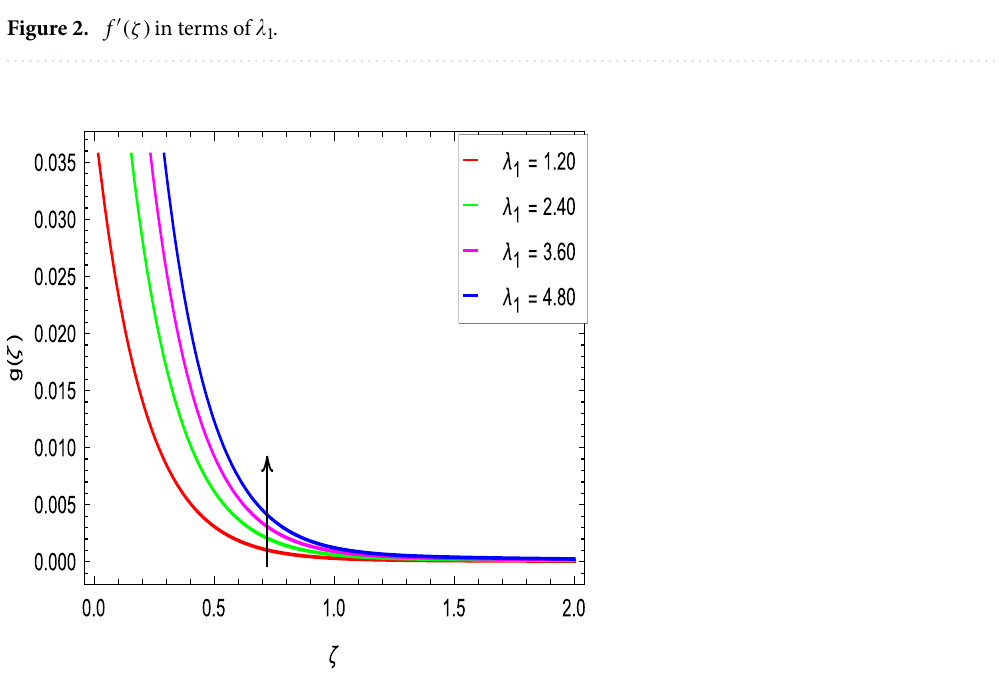
Figure 3. g (ζ) in terms of (cid:31) 1